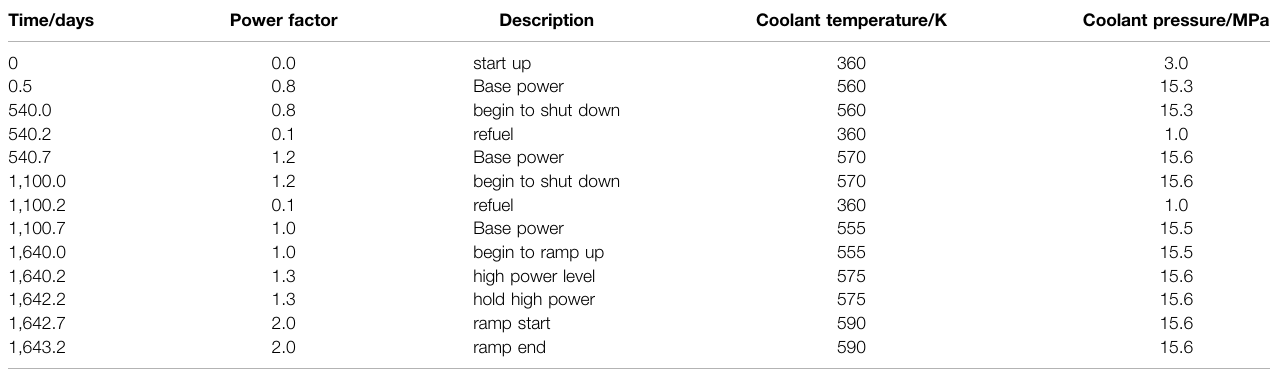
TABLE 1 | Power history and time dependent boundary conditions in modeling. Time/days